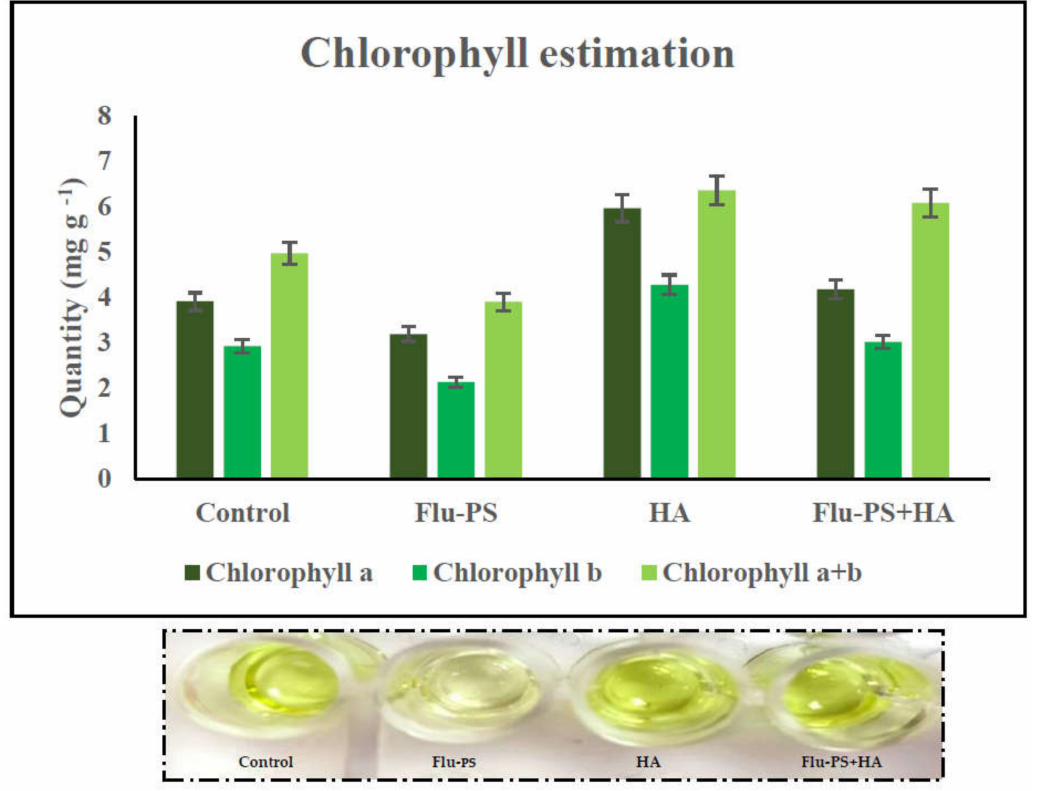
Figure 10. Chlorophyll estimation: effects of the control, Flu − PS, HA and Flu − PS+HA on Solanum lycopersicum